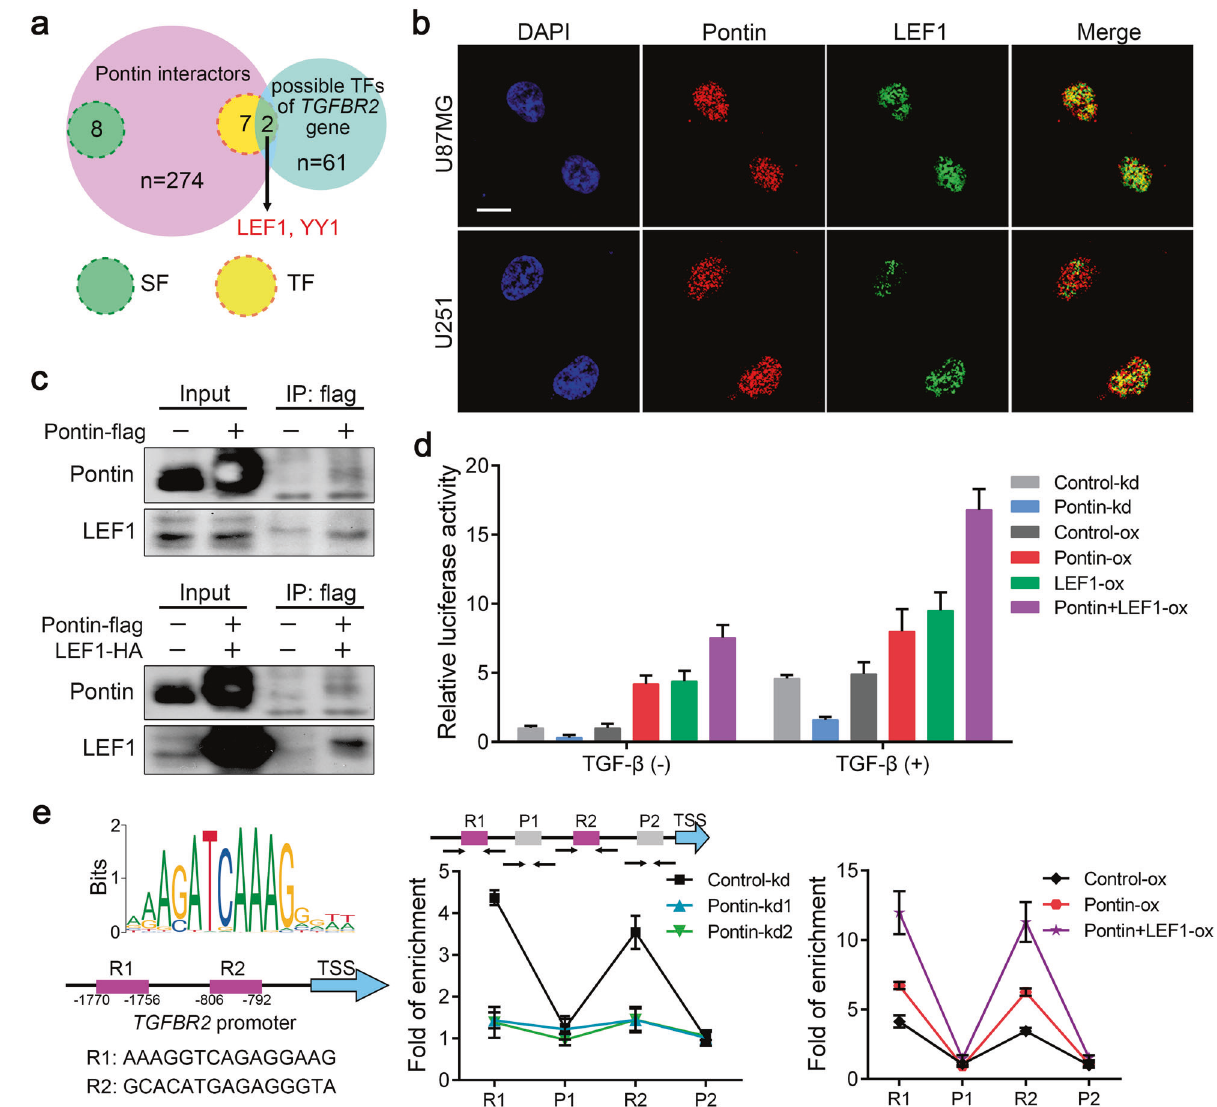
Fig. 6 Pontin interacts with LEF1 to activate TGFBR2 gene transcription in GBM cells. a Venn plot showed the overlapping of Pontin interacting proteins with possible transcription factors regulating TGFBR2 gene expression. SF splicing factors, TF transcription factors. b Representative images showing that Pontin (red) colocalized with LEF1 (green) in U87MG and U251 cell nuclei. Scale bar, 10 μ m. c Co-IP con fi rmation of the interaction between Pontin ( fl ag-tagged) and endogenous LEF1 (upper) or HA-tagged LEF1 (bottom) in U87MG cells. d Effect of Pontin or LEF1 on the luciferase transcriptional response of the reporter driven by TGFBR2 promoter ( − 2000 to 0). e LEF1-binding sites predicted in the TGFBR2 promoter (left) and ChIP-qPCR analyses of the capacities for them to bind with LEF1 (right). Data in d, e are expressed as means ± SDs, n =